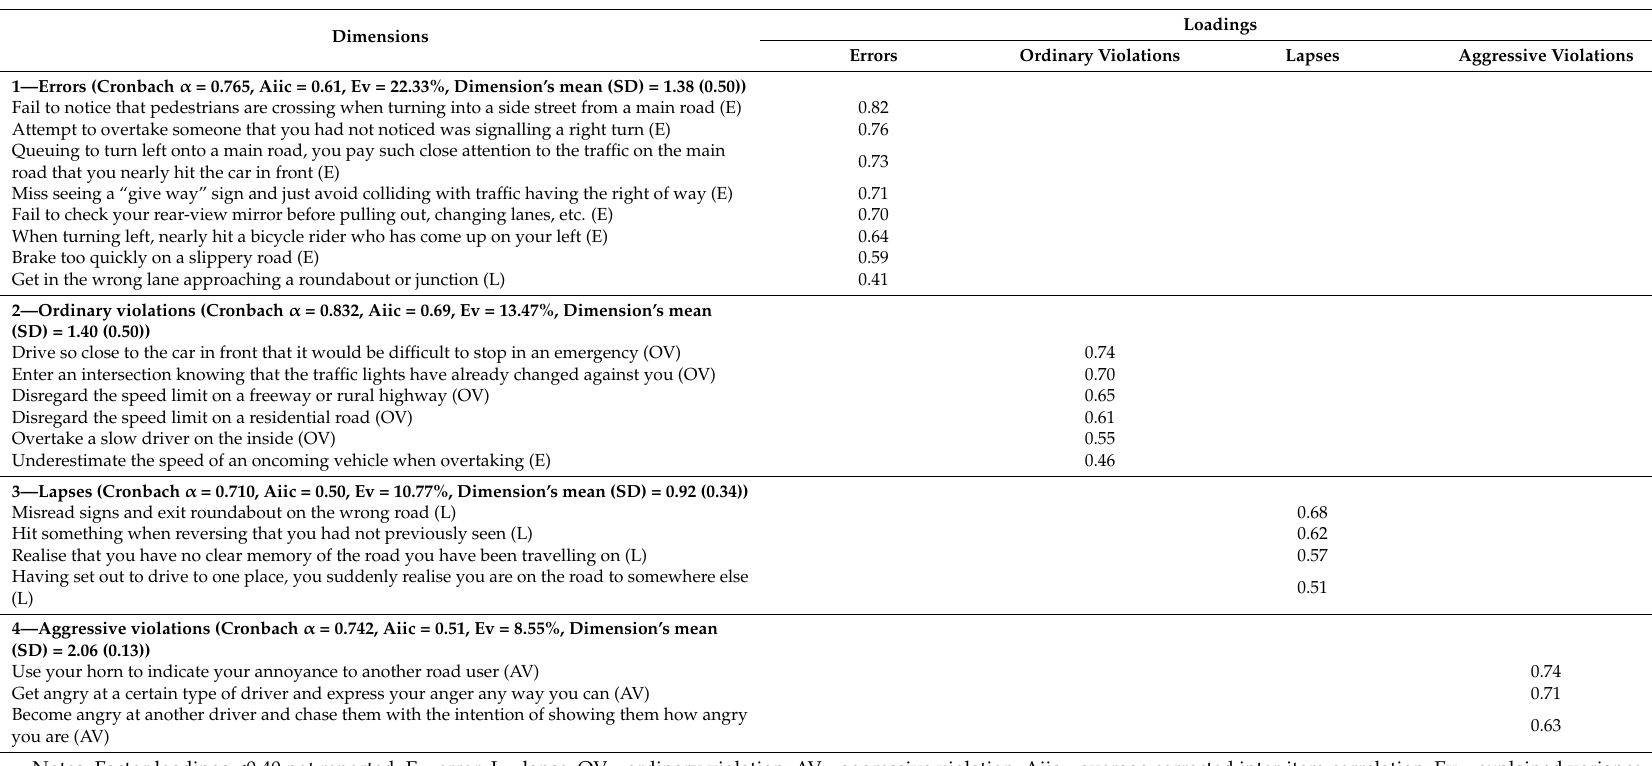
Table 3. Principal component analysis (PCA) for the DBQ